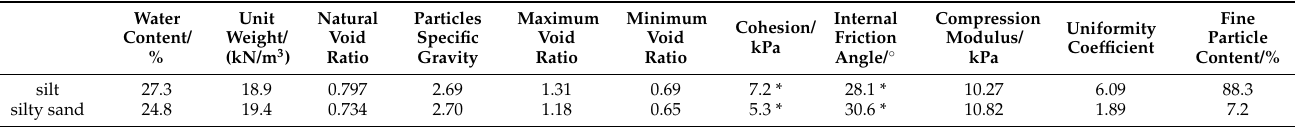
Table 1. Physical and mechanical properties of soils.